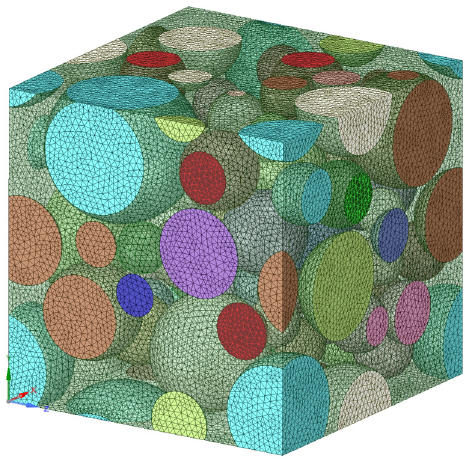
Figure 8. Random particle type RVE with a martensitic volume fraction of 0.9.